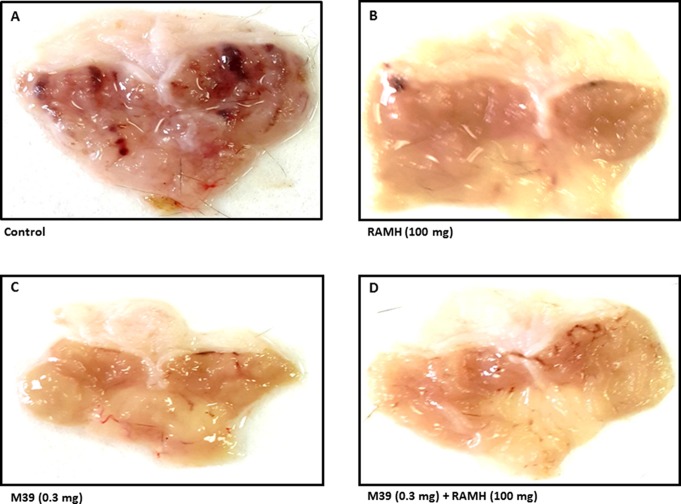
Photomicrographs of stomachs showing the effect of vehicle, H3R agonist (R)-α-methylhistamine, and test compound M39 on stomach ulcer of C57BL/6 mice. Micrographs are the results of five to six such experiments. showing the effect on acidified ethanol in (A) vehicle-, (B) RAMH(100mg/kg)-, (C) M39(0.3mg)-, and (D) M39(0.3mg)+RAMH(100mg)-treated group in reducing the stomach ulcers.